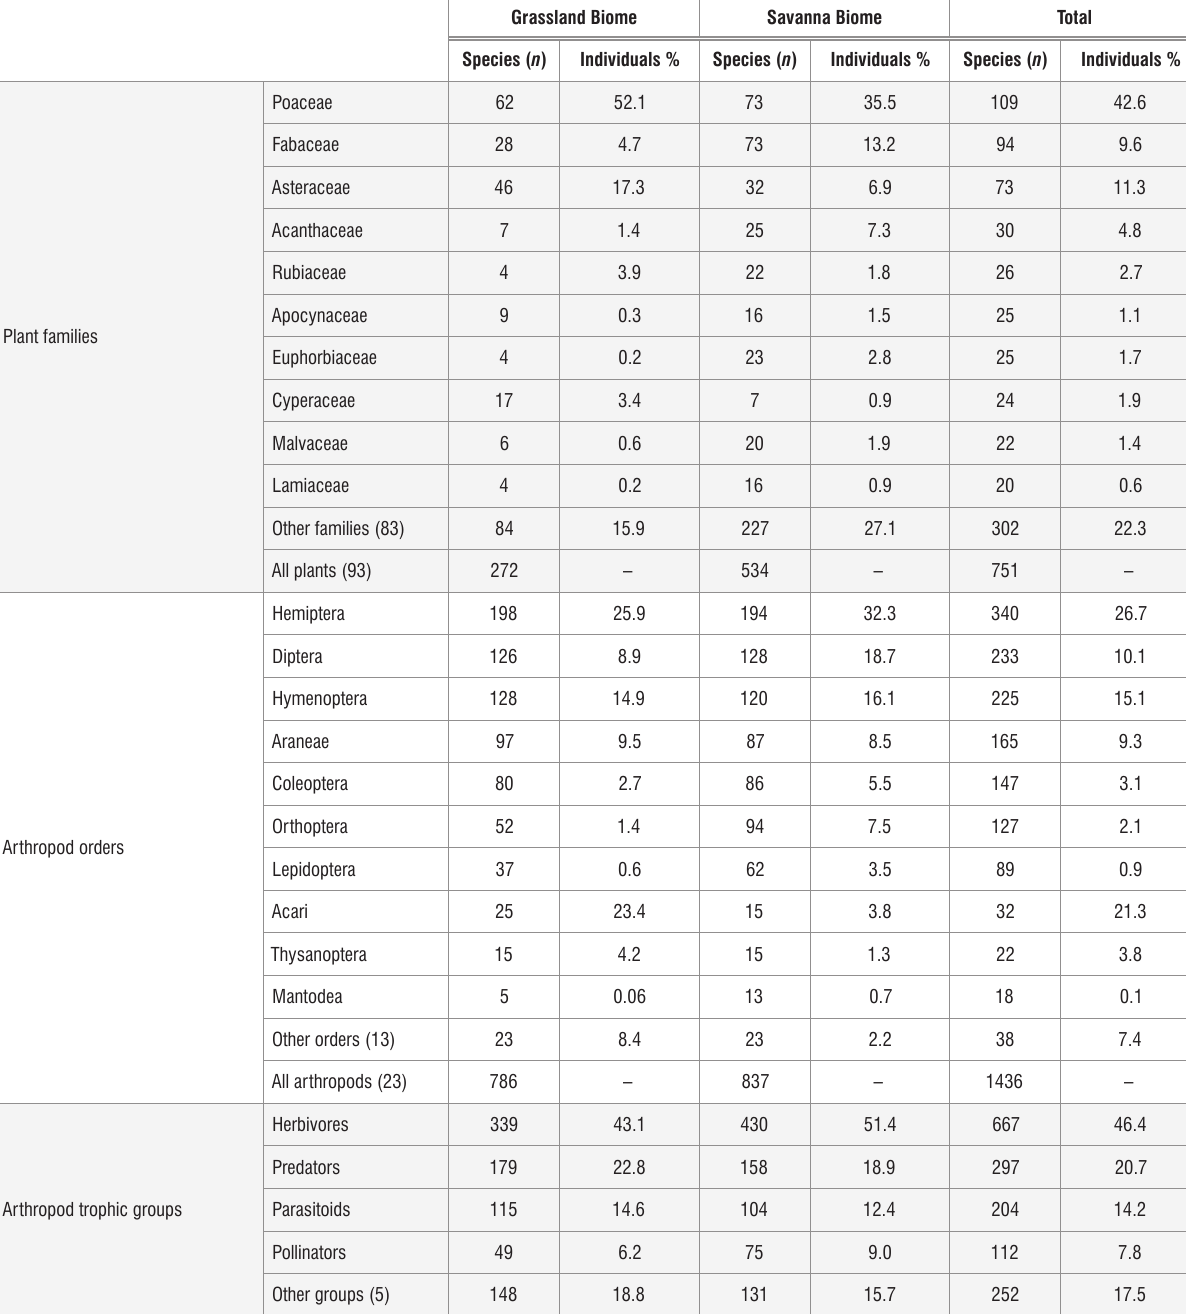
Number ( n ) of plant and arthropod species, and percentage of individuals per family, order or trophic group, and for each biome Grassland